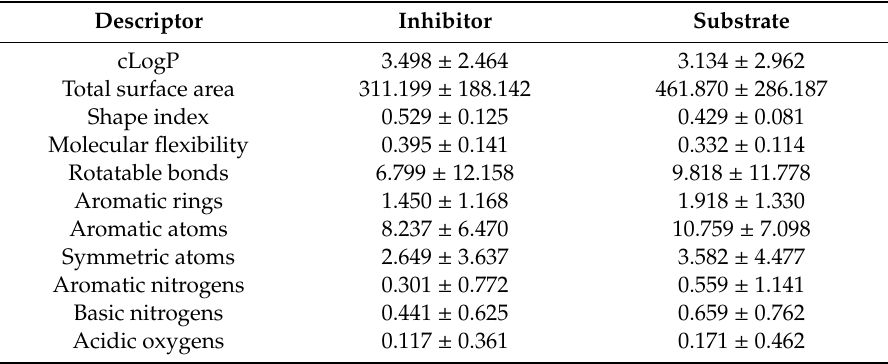
Table 11. Average values of descriptors for inhibitors and